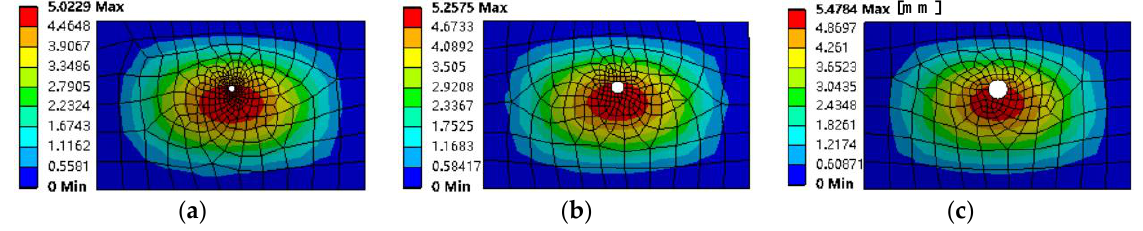
Figure 12. Response diagram of variable aperture plate. ( a ) 20 mm diameter. ( b ) 40 mm diameter. ( c ) 60 mm